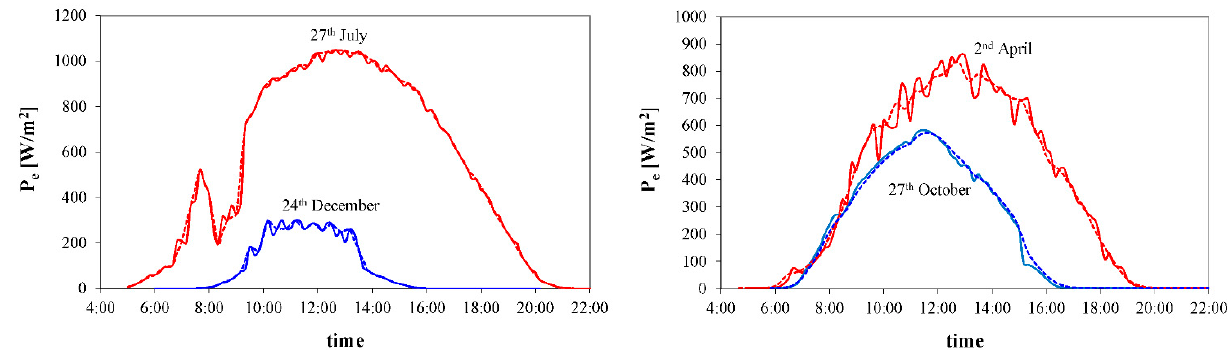
Figure 4. Measured and computed waveforms of power density of irradiation in the location of the photovoltaic installa- tion on selected days .